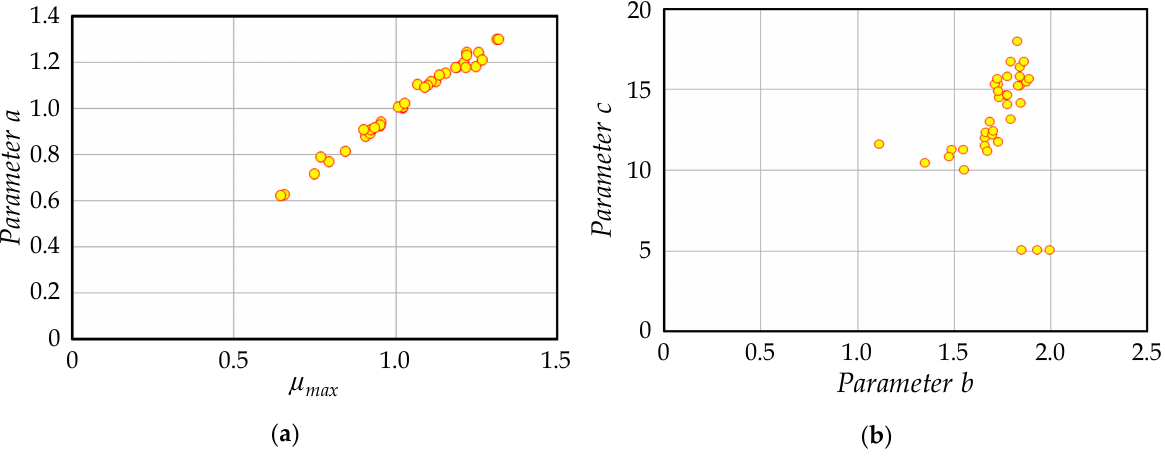
Figure 10. Comparison between the experiment and identification results [4].